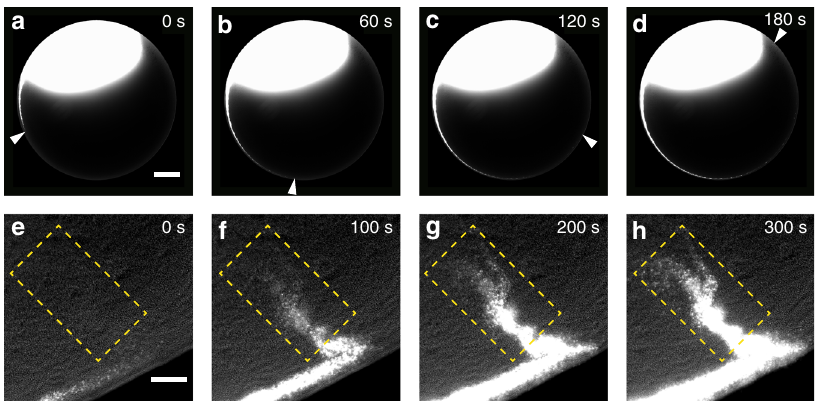
Fig. 4 Long-range, colony-scale directed transport in a P. mirabilis colony. a – d Image sequence showing the directed transport of 0.1- μ m fl uorescent microspheres in the inner motile ring around colony edge ( “ Methods ” ). Fluorescent images of microspheres were overlaid with phase contrast images of the colony (at low light intensity). Bright blob in the upper part of the images is where the fl uorescent microspheres were deposited. Arrows indicate the position of microspheres transported for the longest distance at indicated times; these foremost microspheres are only visible when enlarging the fi gure or when viewing the associated Supplementary Movie 11. Scale bar, 500 μ m. e – h Image sequence showing the directed transport of 0.1- μ m fl uorescent microspheres inwards along crack-like conduits present near colony edge. The conduits are inside the rectangular area showed in the images. Also see Supplementary Movie 12. Scale bar, 50 μ